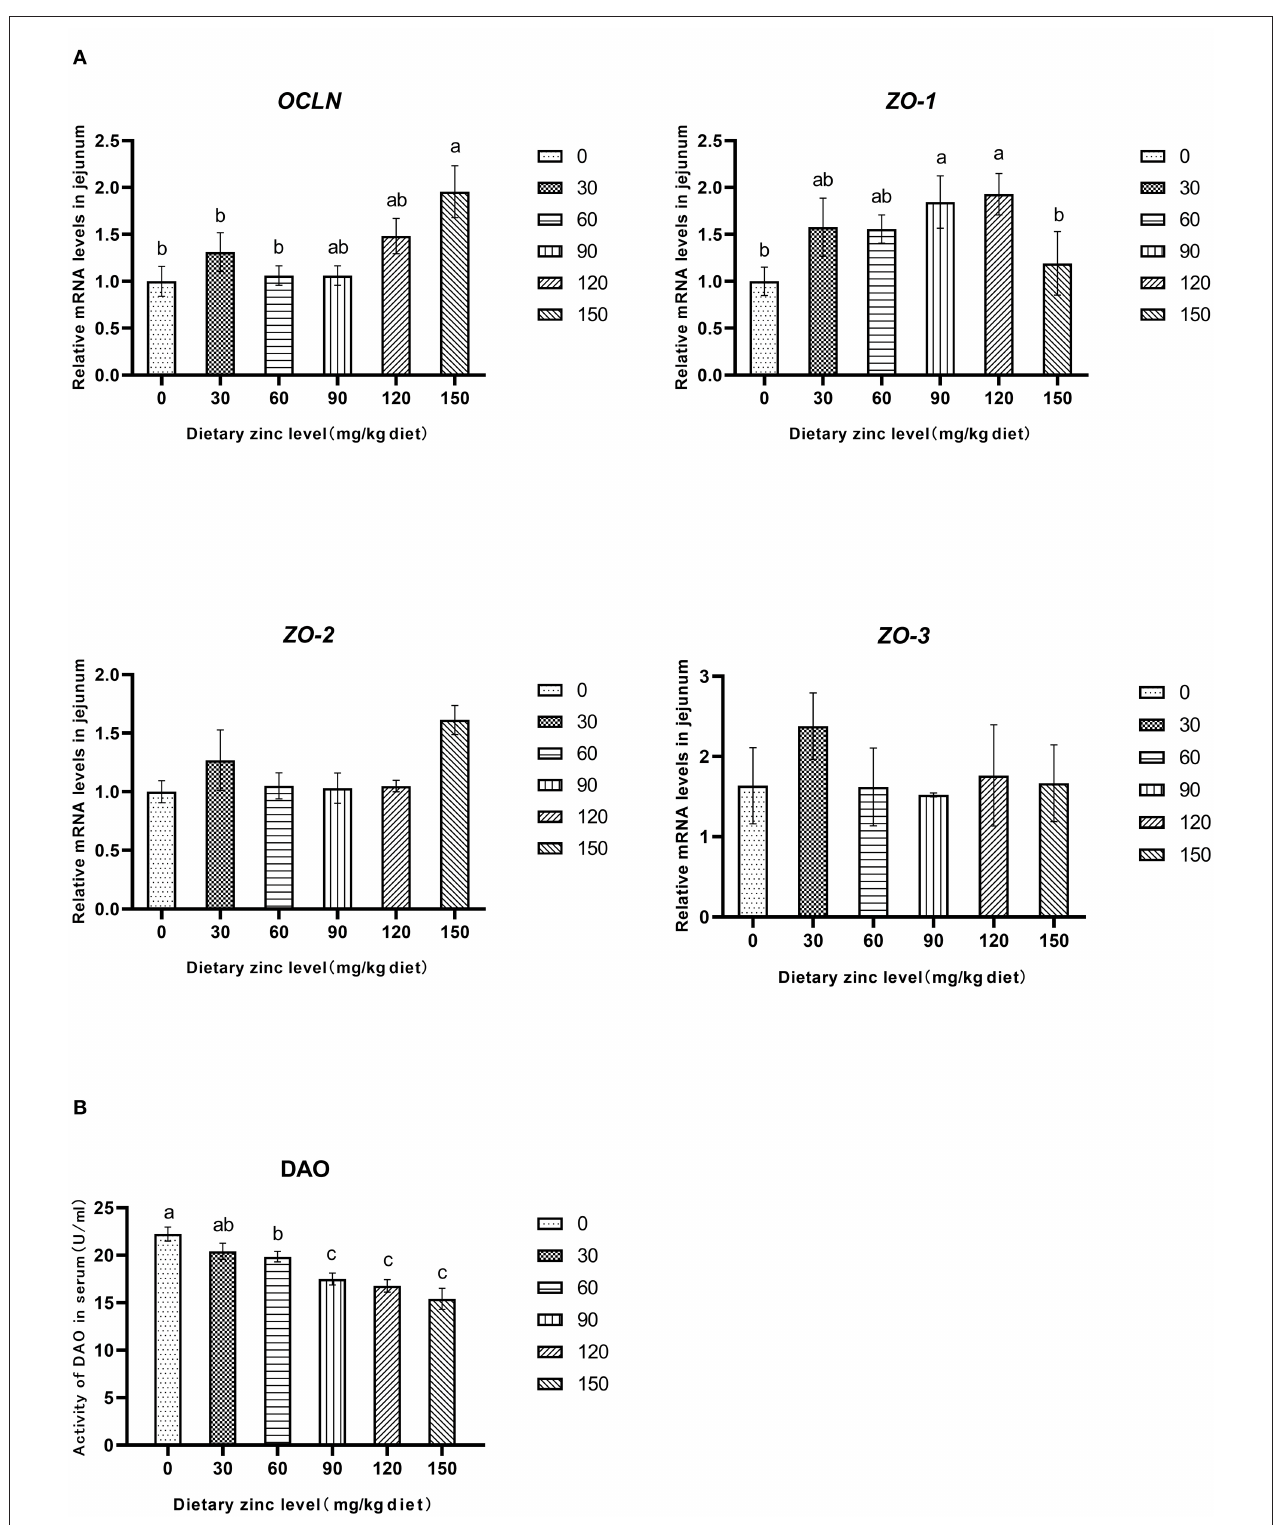
FIGURE 2 | Effects of Zn-Met on gene expression and permeability related to physical barrier of jejunum in meat duck. OCLN, occludin; ZO-1, zonula occludens-1; ZO-2, zonula occludens-2; ZO-3, zonula occludens-3; DAO, diamine oxidase.